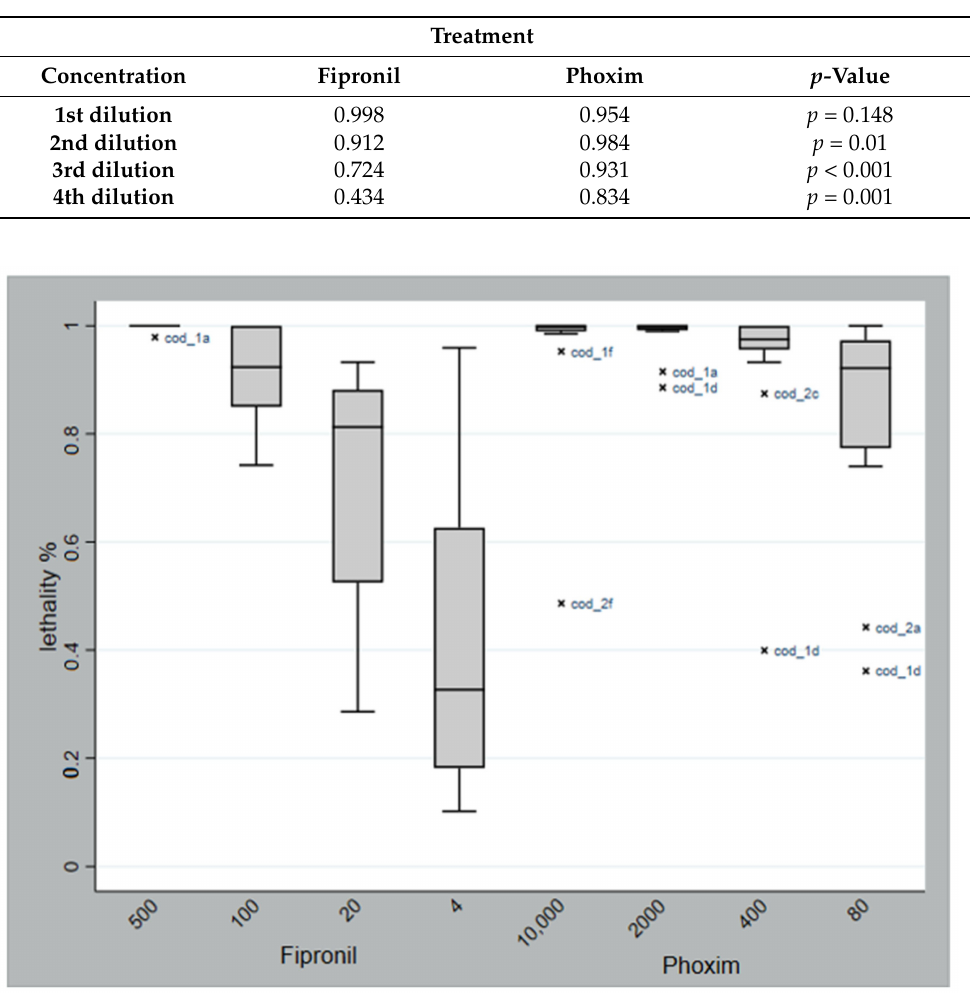
Table 3. Comparison of mean lethality by treatment at the different concentration for fipronil and phoxim, respectively: 1st dilution: 500 and 10,000 ppm; 2nd 100 and 2000 ppm; 3rd 20 and 400 ppm; 4th 4 and 80 ppm.